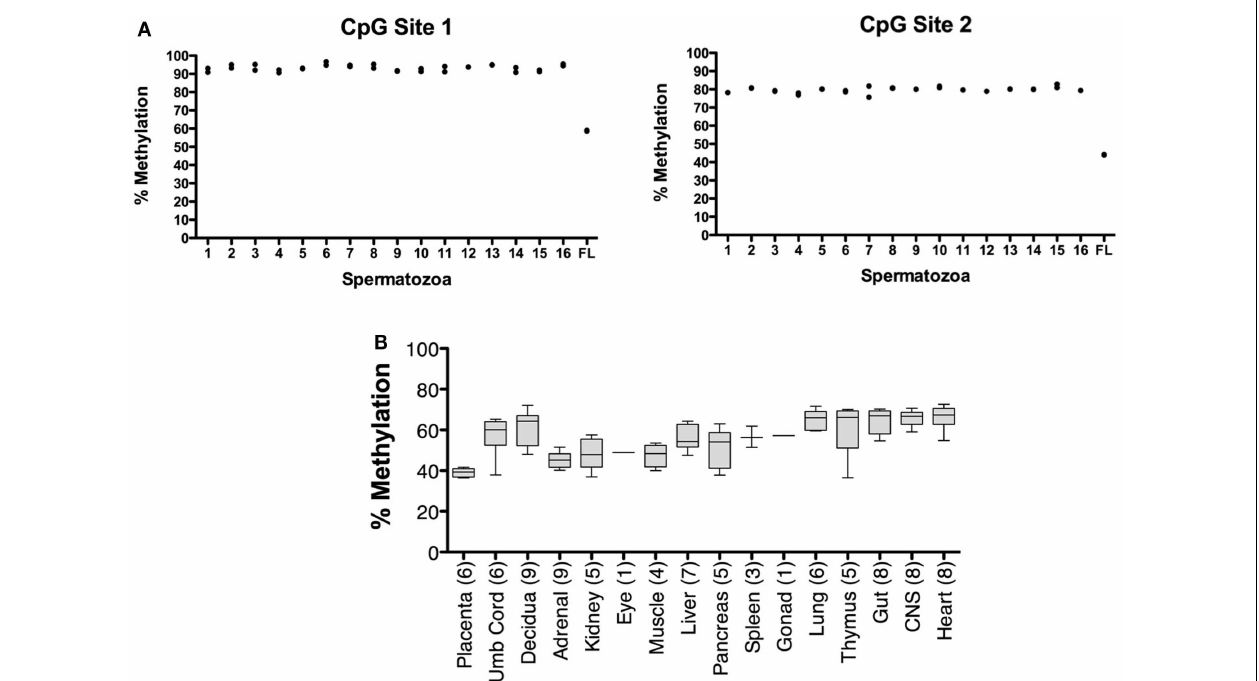
fetal liver (FL).The results from each of two assays are shown. (B) Box and whisker plot showing average percent methylation for the two CpG dinucleotides in the IGF2 intron 3 region across a panel of human conceptal tissues (boxes, 10th to 90th percentile).The number of individuals analyzed for each tissue type is